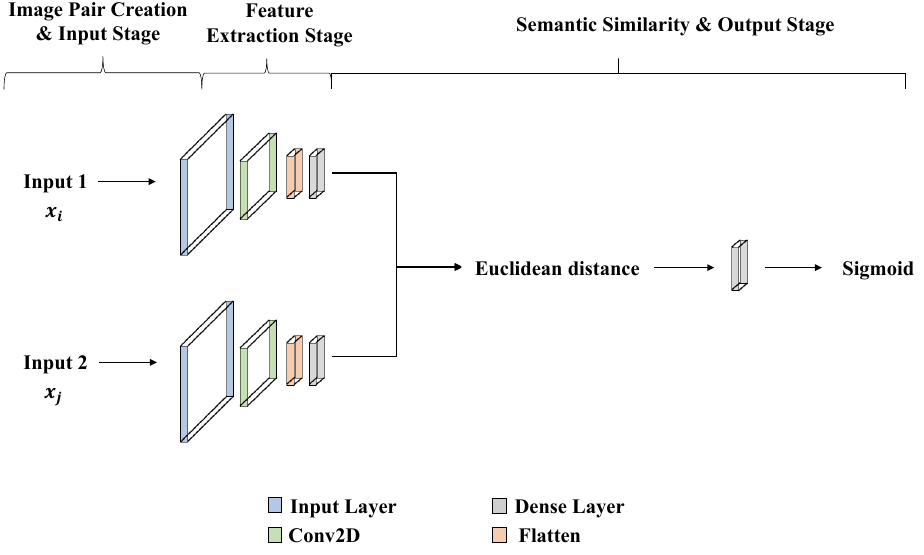
Figure 8. One convolutional layer SNN’s architecture.